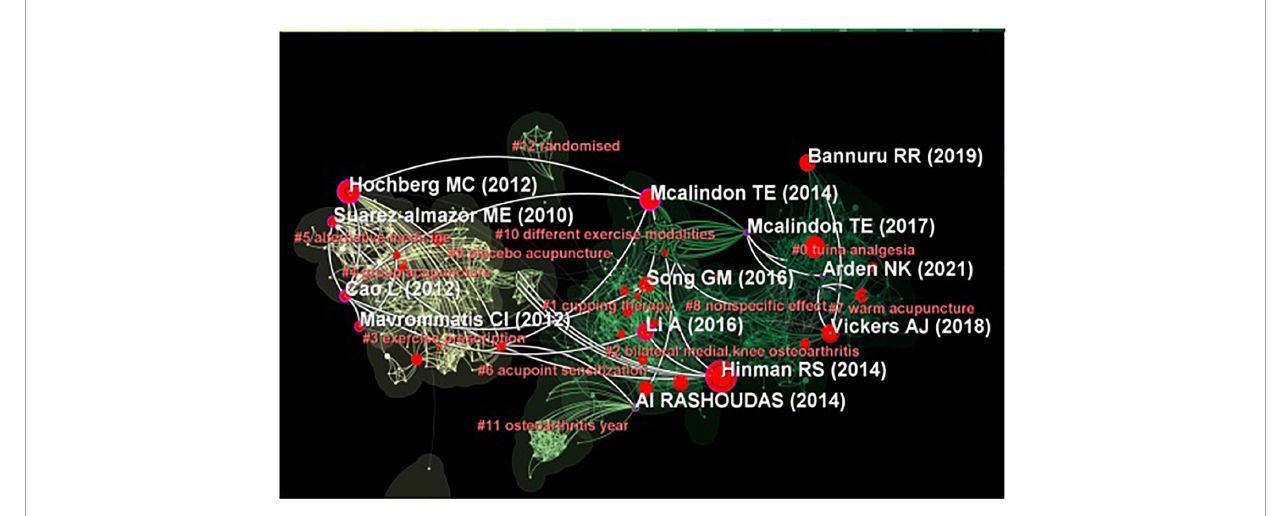
FIGURE6 The network and cluster map of co-cited references related to traditional Chinese non-pharmacological therapies on knee osteoarthritis (KOA).